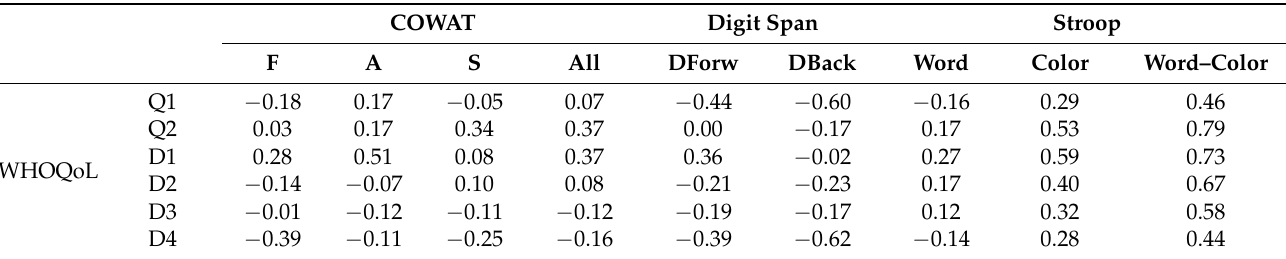
Table 5. Spearman’s rank order